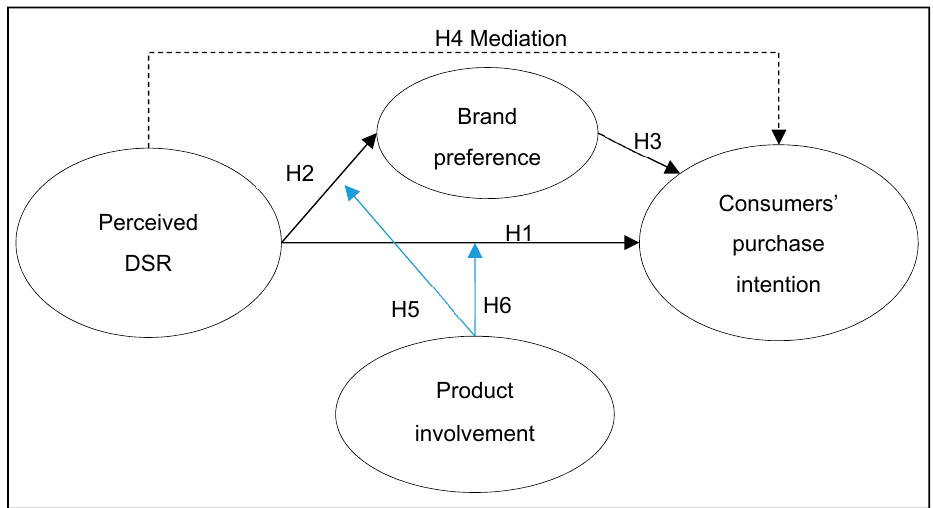
Figure 1. The conceptual framework and measurement model of this study.